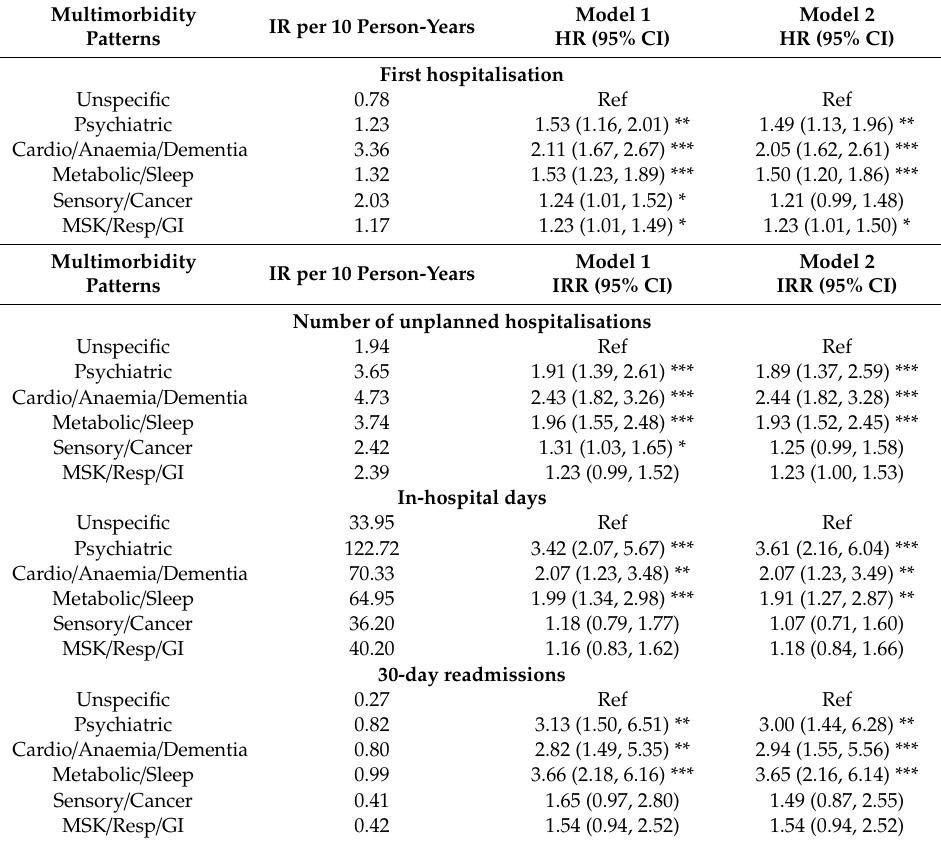
Table 2. Association of multimorbidity patterns with unplanned hospital care utilisation. Multimorbidity Patterns